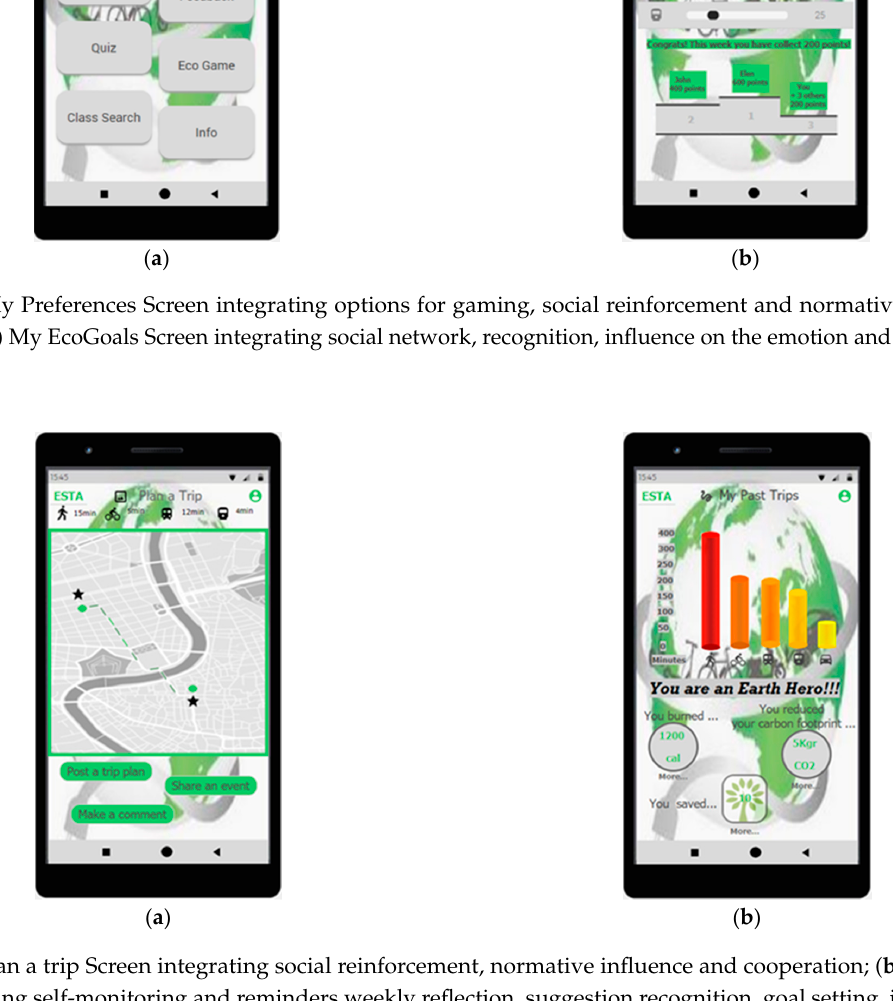
Figure 3. ( a ) My Preferences Screen integrating options for gaming, social reinforcement and normative influence and cooperation; ( b ) My EcoGoals Screen integrating social network, recognition, influence on the emotion and self-monitoring and reminders.